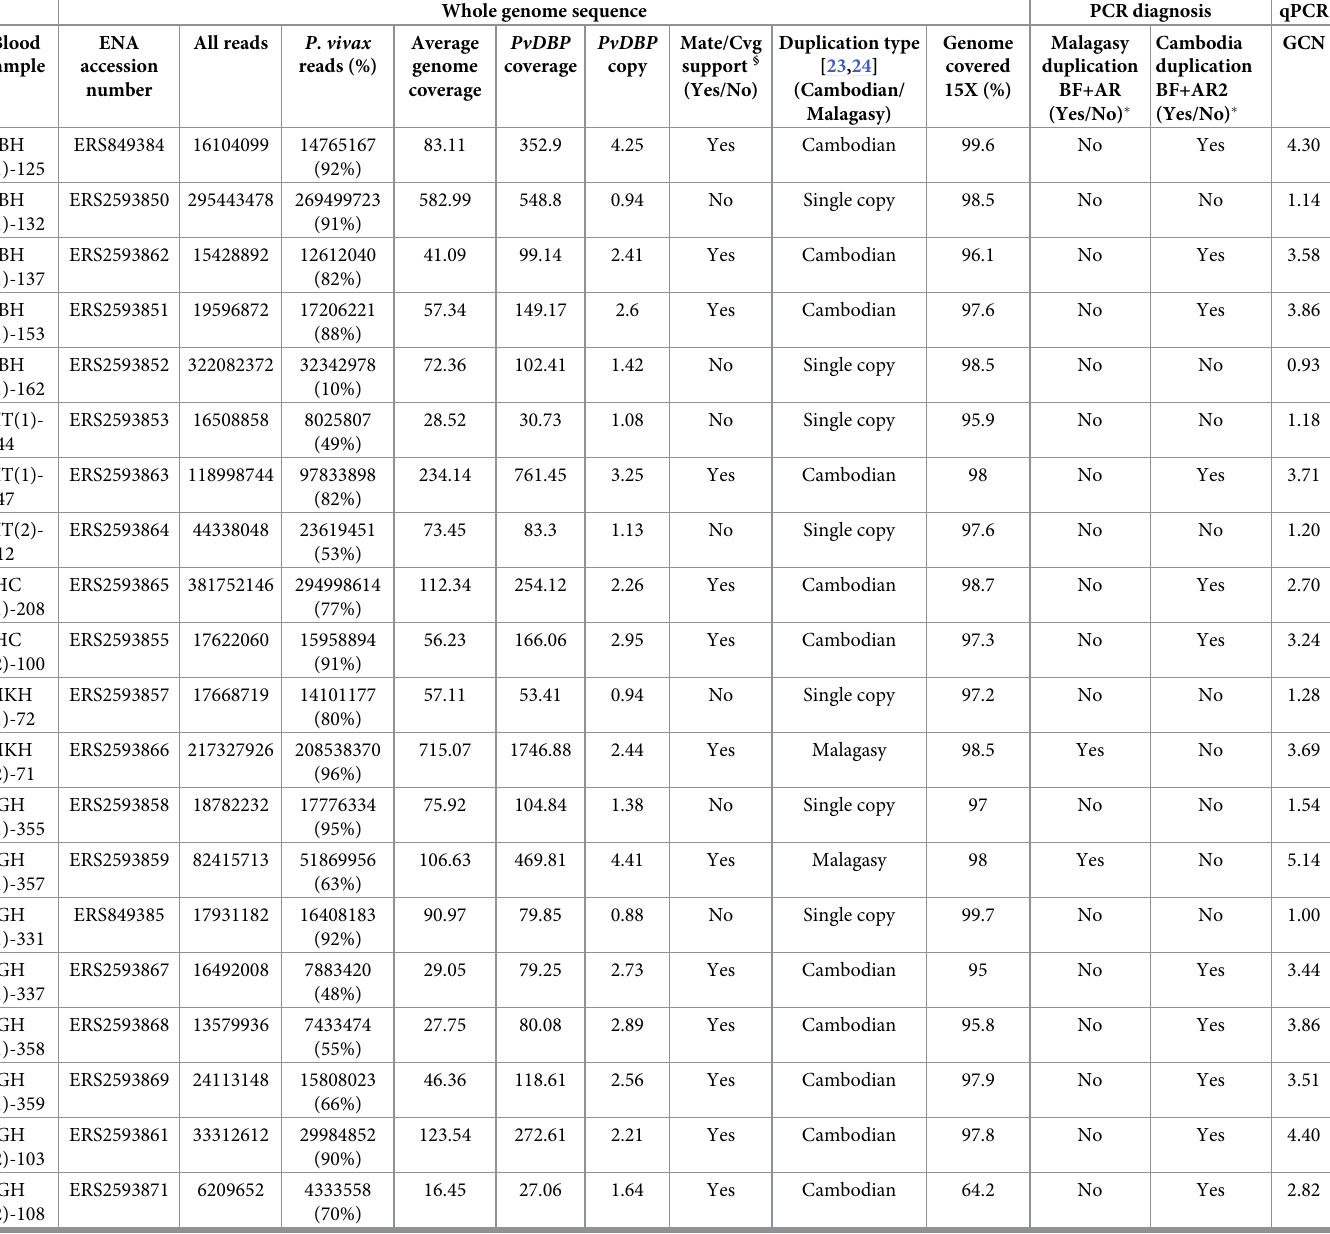
Table 1. Information of whole genome sequences of 20 Plasmodium vivax isolates from Ethiopia. The European Nucleotide Archive (ENA) accession number for all files (ERP012186). Whole genome sequence PCR diagnosis Blood ENA sample